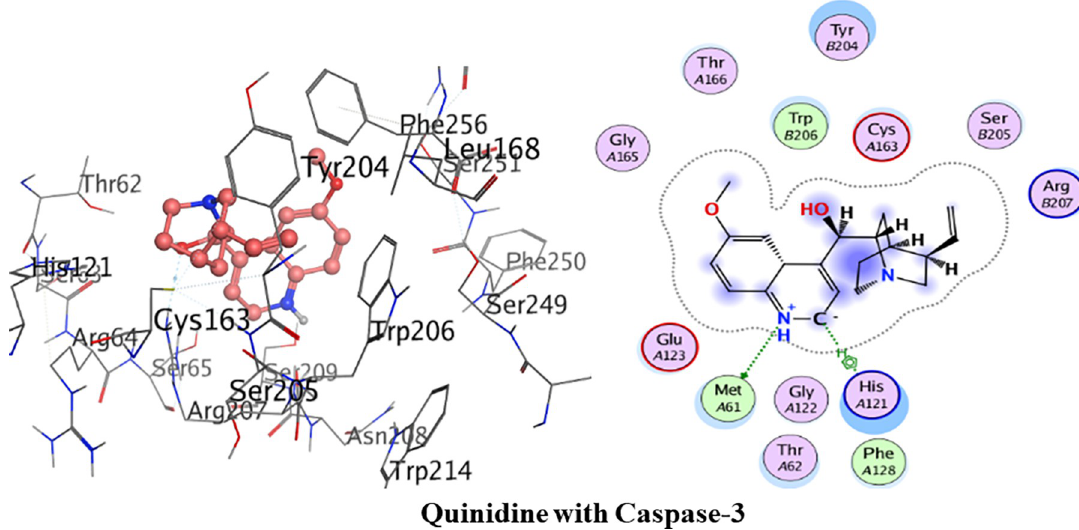
Fig 15. 3D and 2D interactions of quinidine with active site of